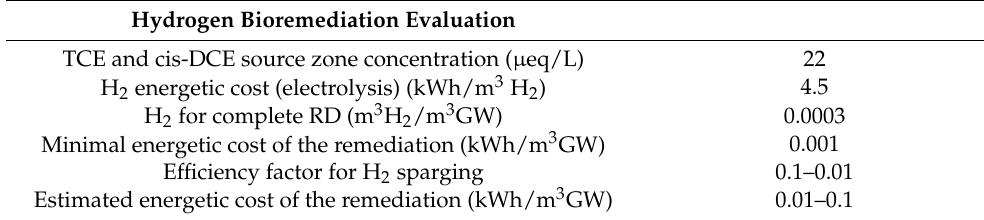
Table 2. Energetic cost of H 2 sparging approach for the evaluated case study 1 . Hydrogen Bioremediation Evaluation